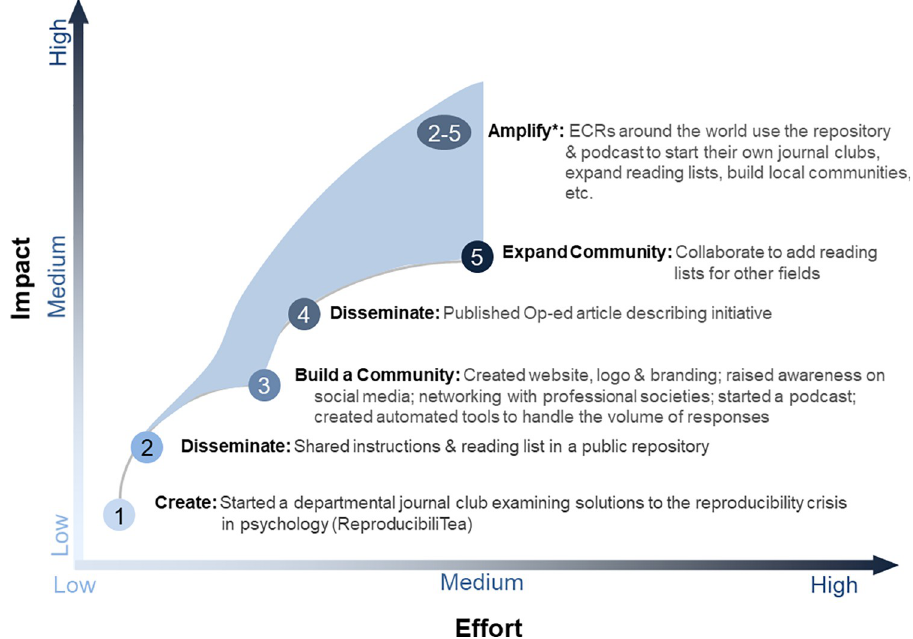
Fig 2. Balancing effort and impact in science reform initiatives. ECRs who are developing an initiative should consider the amount of effort that each stage will require and the potential impact. Actions that allow others to reuse materials to start their own initiatives can amplify impact by expanding the initiative’s reach. This conceptual figure illustrates the relationship between effort and impact for the ReproducibiliTea journal club initiative [23]. The effort and impact values are subjective. Furthermore, it is difficult to determine which specific actions had the greatest impact. Organizers may implement several new approaches simultaneously. Impacts are often delayed, as awareness of initiatives builds over time. Finally, it is important to note that this diagram was based on a successful initiative. Not all initiatives are successful and effort does not always increase impact. Organizers should prioritize actions that they think are most likely to increase impact, then adapt their strategy based on the results. ECR, early career